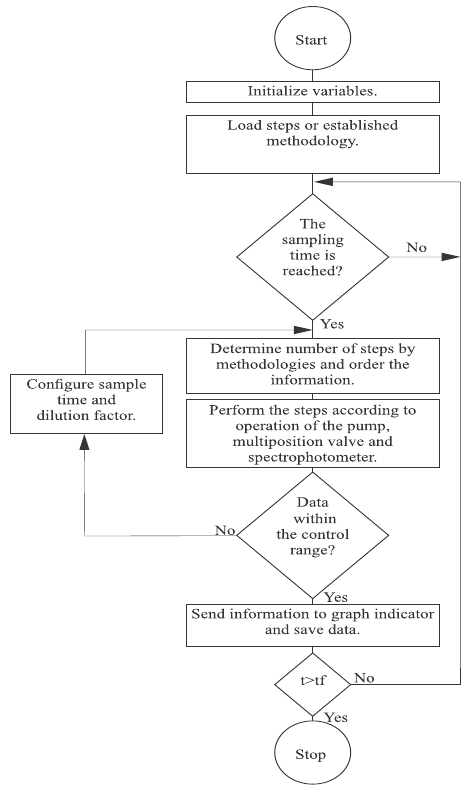
Figure 4. Operational flow diagram for the SIA